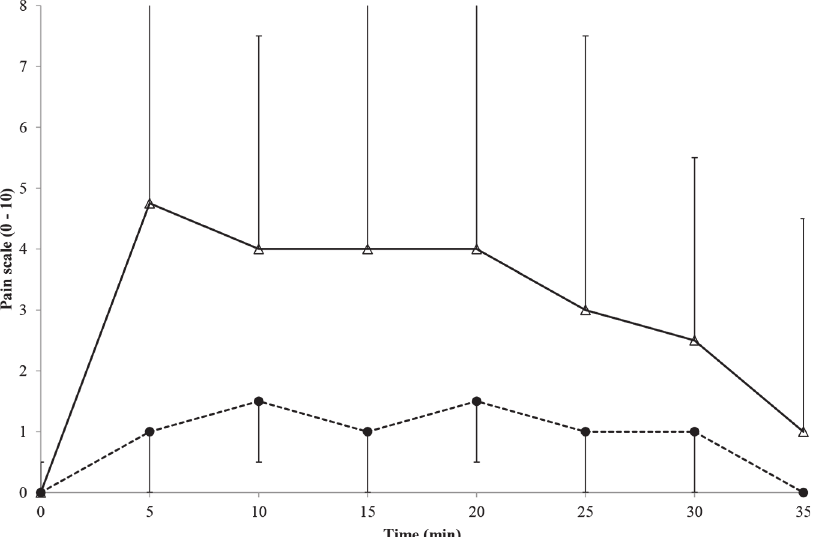
Fig 4. Median (range) pain sensation during immersion and recovery. Dashed line = 8°C trial; solid line = 0°C